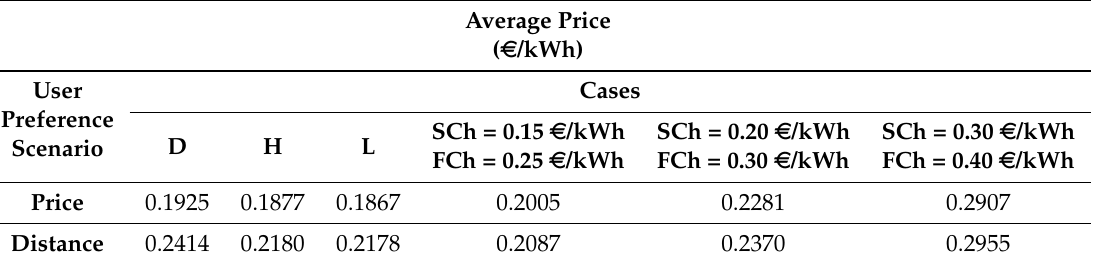
Table 11. Spent average charge price of the EV users for dynamic and fixed